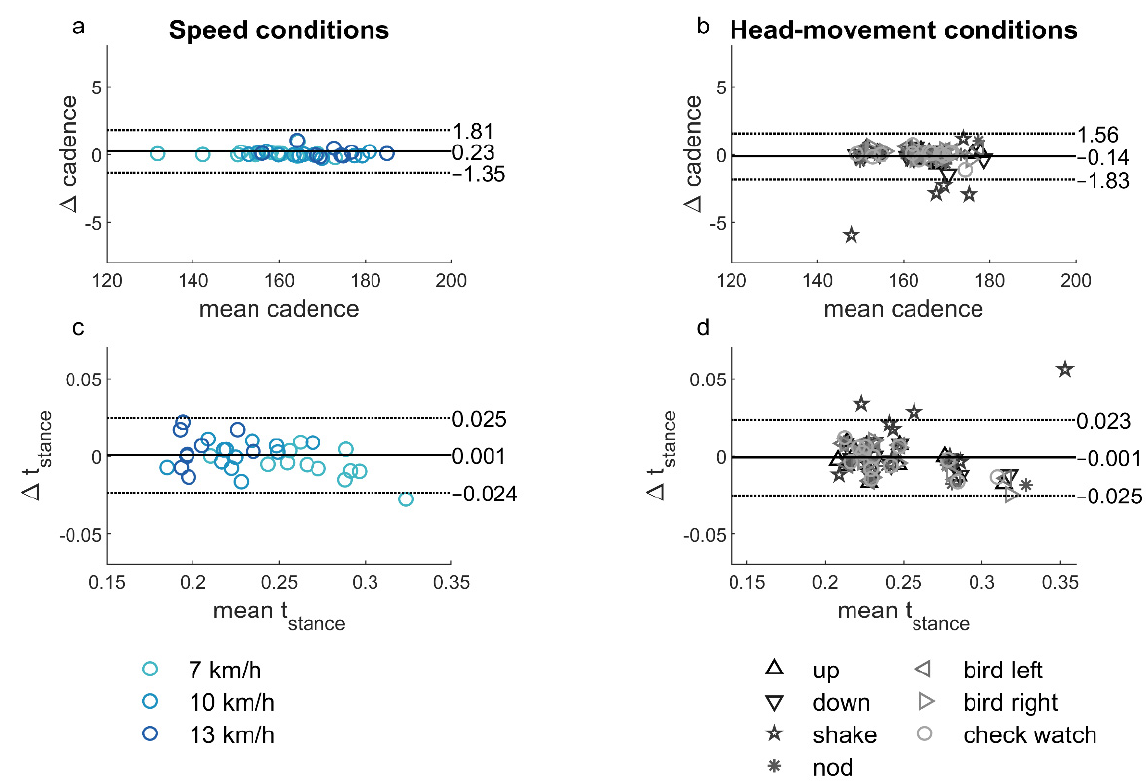
Figure 6. Bland–Altman plots showing the agreement of cadence ( a , b ) and stance time ( c , d ) between earbud and force-plate methods for the different speed conditions (test and retest combined; ( a , c )) and the head-movement conditions ( b , d ). Table 3. Between-methods bias and agreement of cadence and stance time between earbud and force-plate methods for the speed conditions (bias = earbud − force plate).